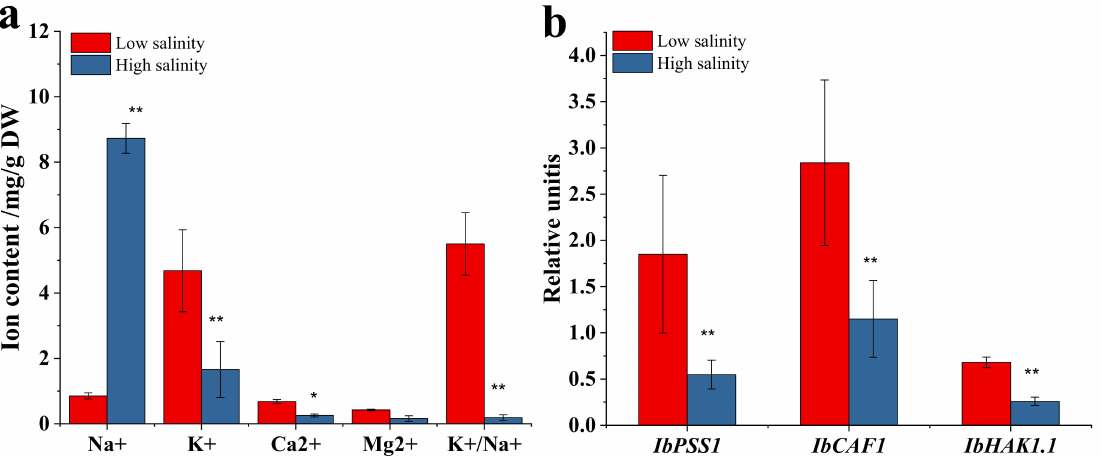
Figure 4. Concentrations of inorganic cations and the K + /Na + ratio in storage root of purple sweet- potato across different treatments ( a ). Expression of genes involved in Na + and K + transport in storage root of purple sweetpotato across differential salinity ( b ). Columns represent mean val- ues ( ± SD) of three biological replicates. Datasets with the same letter do not significantly differ (* p < 0.05, ** p <